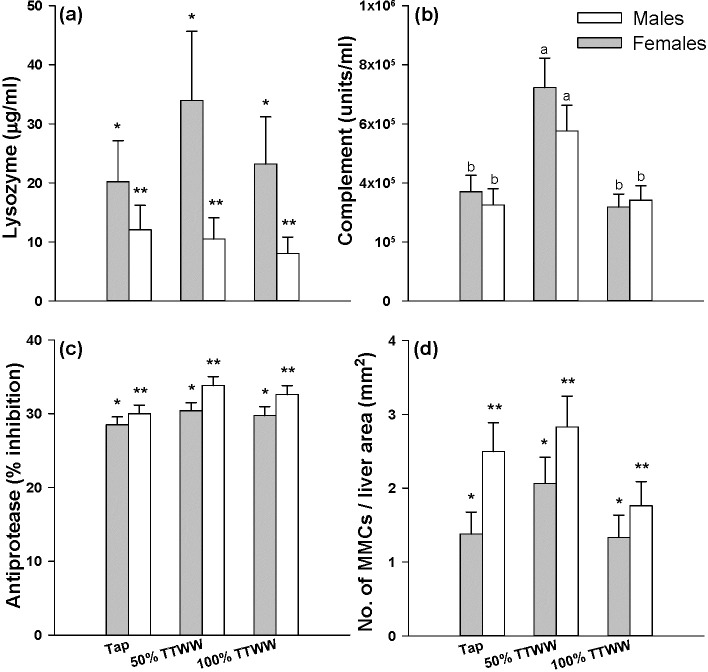
Immunological parameters measured in analyses of whole body homogenates (a-c) or in histopathology examination (d). (A) Lysozyme concentration (μg/mL), (B) Complement concentration (units/mL), (C) Anti-protease (% inhibition) and (D) ratio of the number of MMCs per liver area in mm2 in males and females from different treatment groups. a, b, different letters denote significant differences between treatment groups (p < 0.05); *, ** different signs denote significant differences between males and females (ANOVA, p < 0.05).